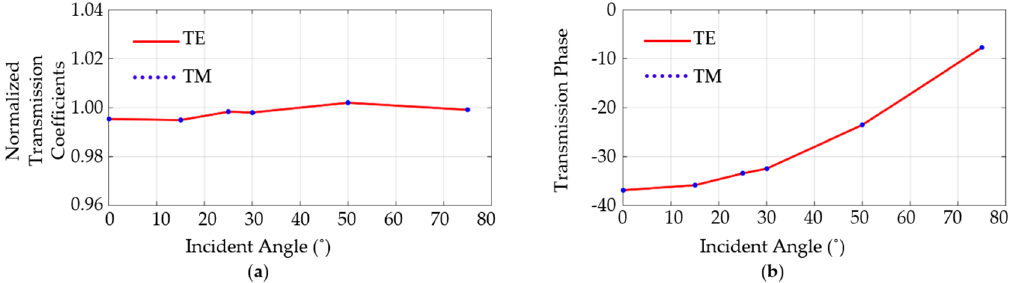
Figure 6. Radome 10 GHz transmission coefficients of TE and TM modes with different incident angles: ( a ) Normalized transmission coefficients; ( b ) transmission coefficients phase.